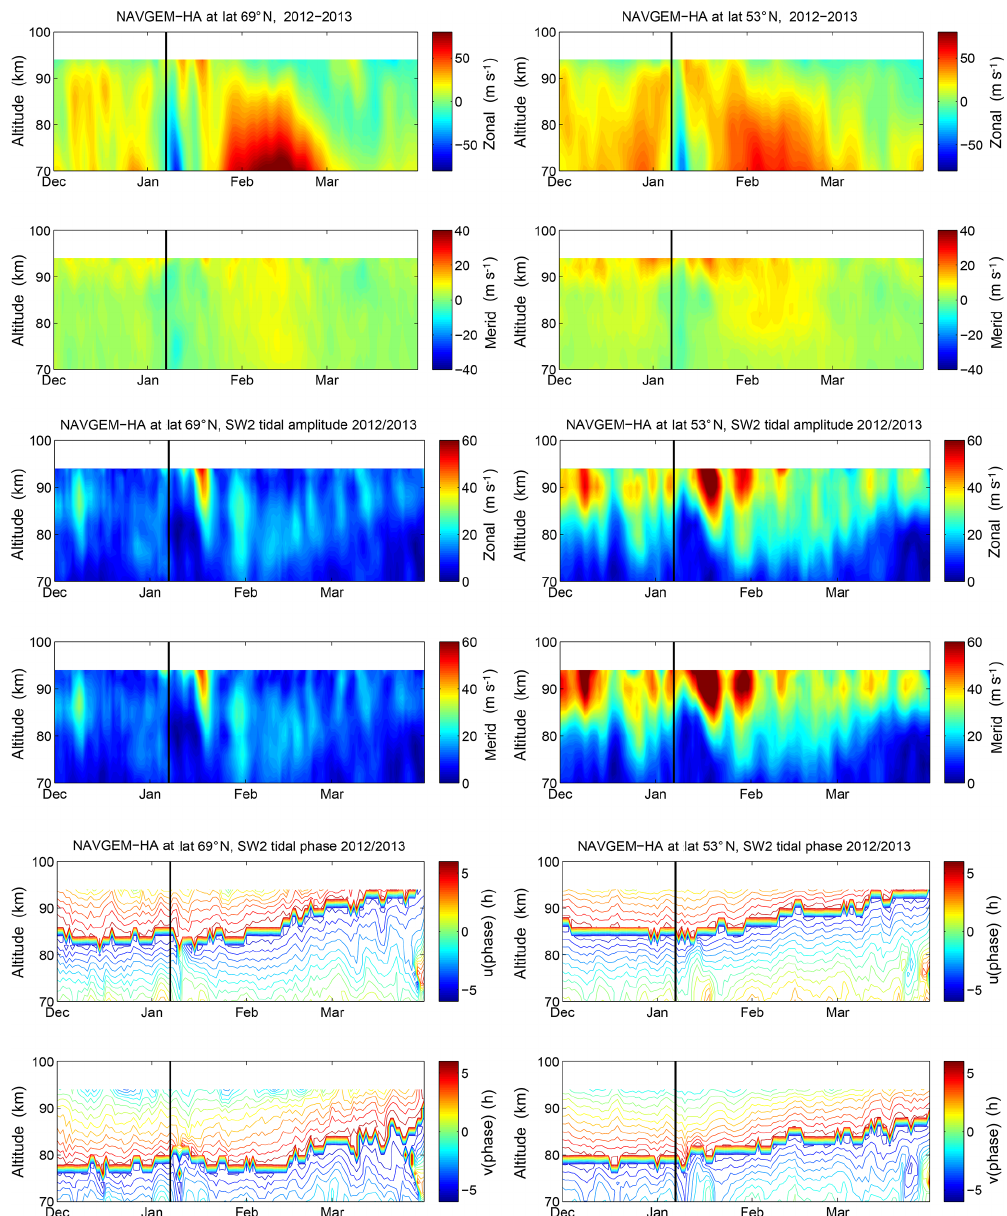
Figure 11. Comparison of global NAVGEM-HA above Juliusruh (left column) and Andenes (right column) during the winter of 2012/13 for daily zonal mean zonal and meridional winds (two upper panels), zonal mean semidiurnal tidal zonal and meridional amplitude (middle panels) and zonal mean semidiurnal tidal phases (two lower